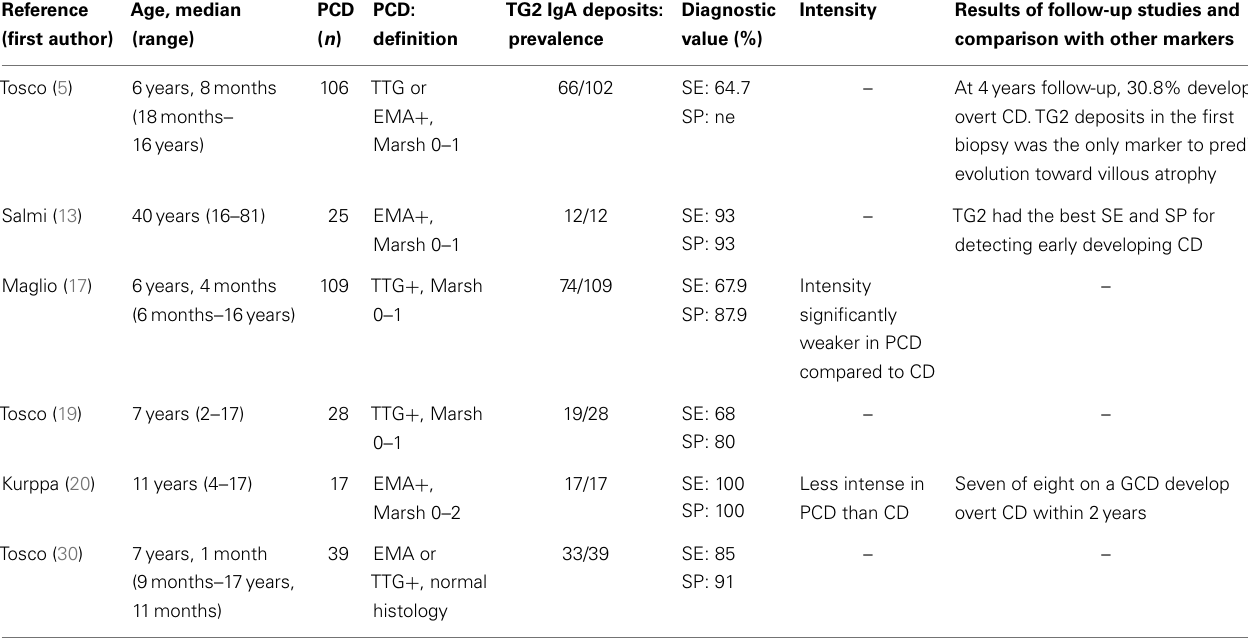
Table 3 | Summary of the included studies evaluatingTG2 deposits in potential celiac disease (PCD)